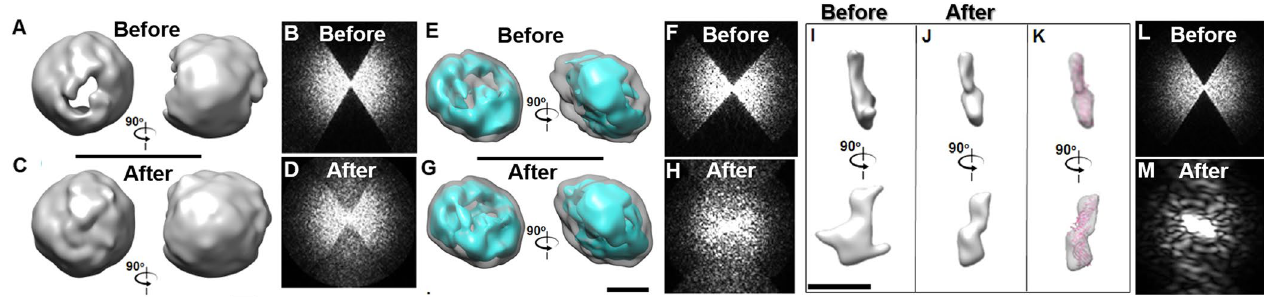
Figure 6. Missing-wedge correction of the cryo-EM single-molecule 3D reconstructions. ( A ) Two perpendicular views of a single-molecule 3D density map of an individual liposome particle reconstructed by IPET on the cryo-EM tilt series (from − 57° to + 60° in steps of 1.5°) after CTF correction and contrast enhancement 25 . The 3D map was low-pass filtered at 70 Å. ( B ) Fourier transform of the X-Z projection of the 3D map. ( C ) The corresponding views of the 3D map after the 1,000 iterations of missing-wedge correction. ( D ) Fourier transform of the X-Z projection of the corrected 3D map. ( E – H ) The missing-wedge correction on a 3D map of an individual LDL particle imaged by cryo-ET and reconstructed by IPET from the tilt series (from − 45° to + 45° in steps of 1.5°). Two Fourier transforms of X-Z projections of the 3D maps before and after correction are shown. ( I – M ) The missing-wedge correction on a 3D map of an individual CETP particle (53 kDa) imaged by cryo-ET and reconstructed by IPET from the tilt series (from − 49° to + 65° in steps of 1.5°). Two perpendicular views and Fourier transforms of X-Z projections of the 3D maps before and after correction are shown. Scale bars: 50 nm in C and G and 10 nm in